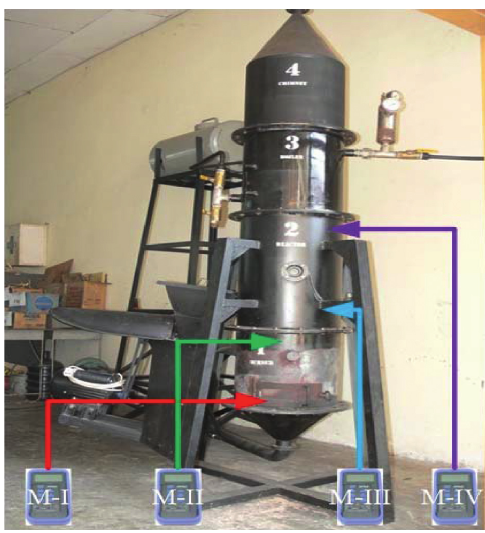
Figure 1: Schematic diagram of the combustion chamber (FBC).